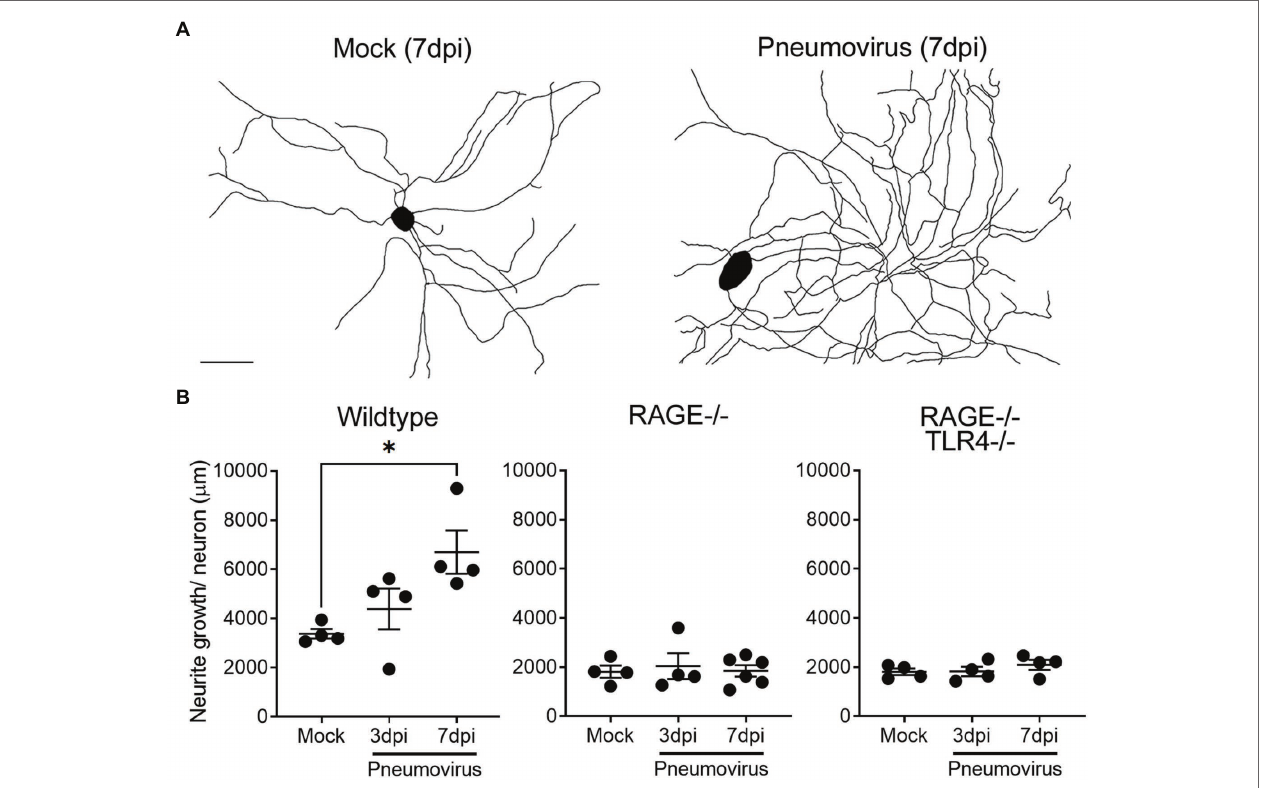
FIGURE 3 | In vivo respiratory pneumovirus infection evokes RAGE-dependent upregulation of vagal sensory neurite outgrowth. (A) Representative neurite outgrowth tracings of cultured vagal ganglia neurons harvested 7 days post-inoculation (7 dpi) in vivo with vehicle or five plaque forming units of pneumovirus (PVM). Scale bar = 50 μm. (B) Quantitative data showing the time dependent (3–7 dpi) effects of in vivo pneumovirus infection on neurite outgrowth in neurons cultured from wildtype, RAGE deficient (RAGE − / − ), and RAGE/TLR4 double deficient (RAGE − / − /TLR4 − / − ) mice. Each dot represents the average neurite outgrowth per cell estimated with an unbiased Petrimetircs probe covering within a 100 × 100 mm grid from one replicate coverslip ( n = 4–6 experiments) with overall group mean and SEM plotted. * p < 0.05 significantly different to 7 dpi mock as determined by one-way